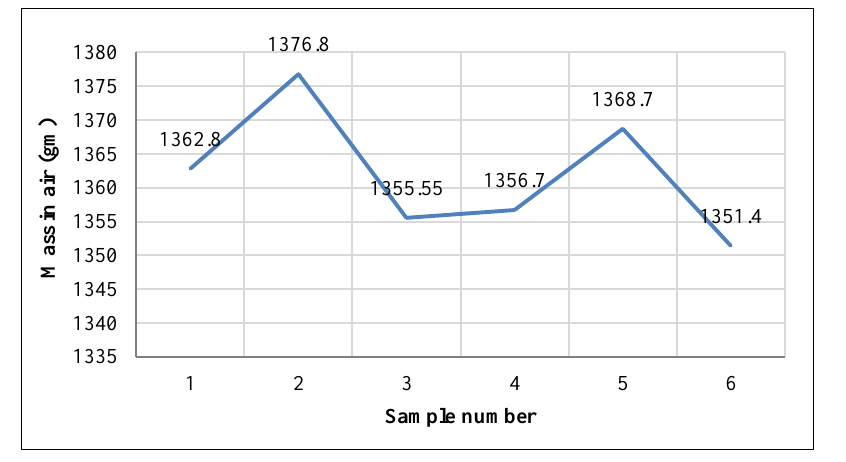
Figure 21. Mass in air values for six batches